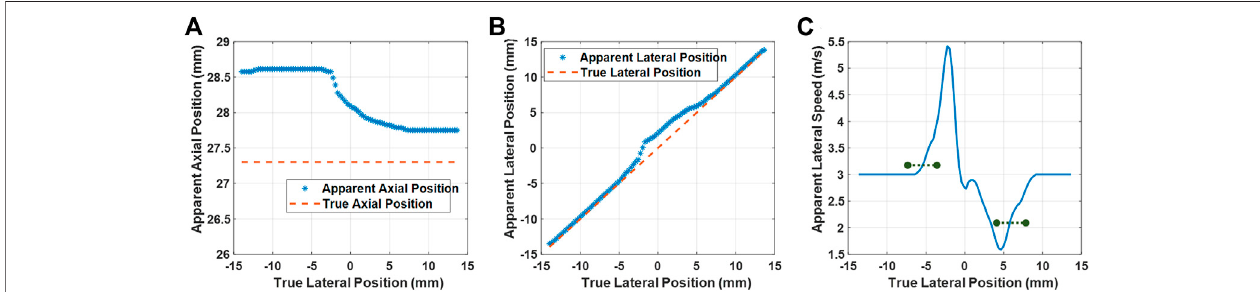
FIGURE 7 | Simulation results. True vs. apparent axial (A) and lateral (B) positions of a scatterer, observed via beamforming with a homogeneous SoS map of 1,580 m/s. Apparent lateral speed (C) computed using the estimators similarly to the experimental case. The black markings represent the mean estimated SWS within the width of the two ROIs used in the experiments and delineated in Figure3(III,b)